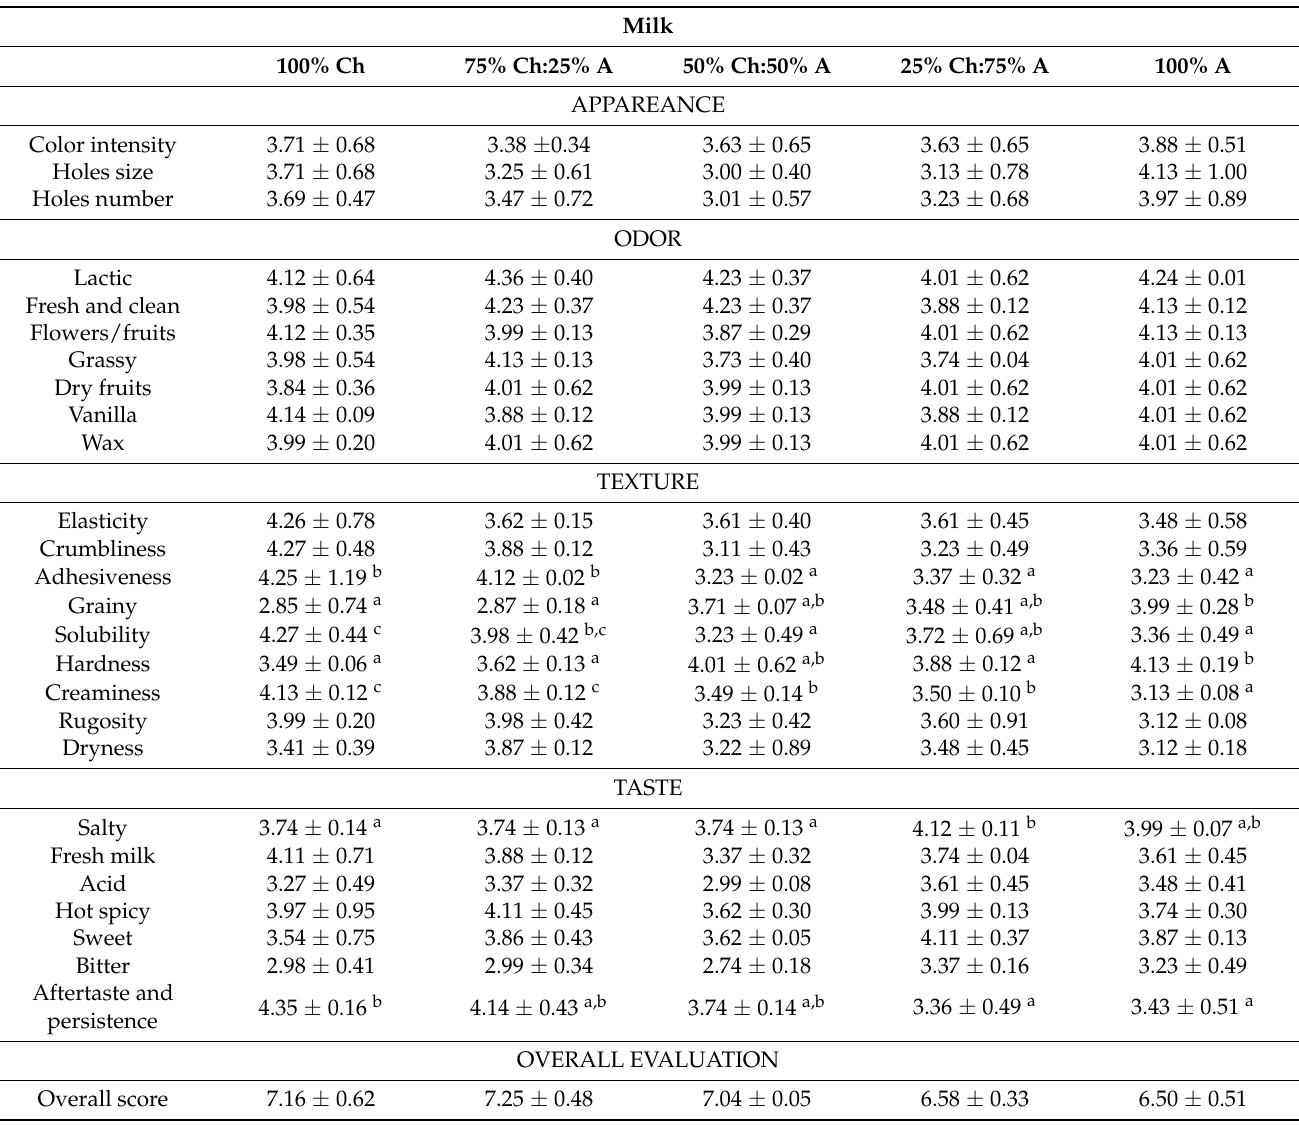
Table 5. Average values assigned by tasting panel for various sensory attributes linked to appearance, aroma, texture and flavor, and an overall evaluation for Zamorano cheese made with milk from Churra (Ch) and Assaf (A) breed after 240 days’